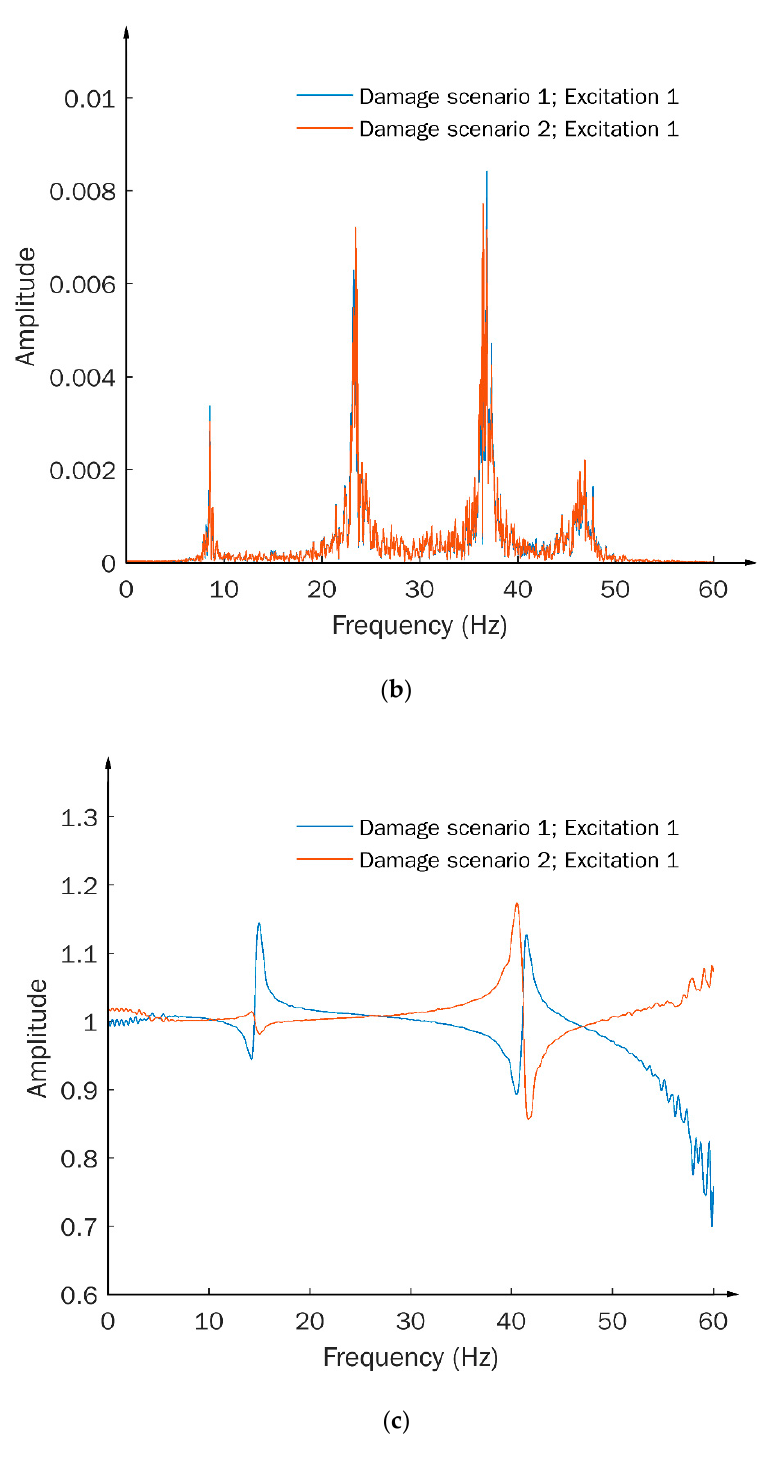
Figure 5. Dynamic responses in terms of ( a ) time series (TS), ( b ) fast Fourier transform (FFT)-based, and ( c ) TF signals, subject to different damage scenarios and the same excitation condition.